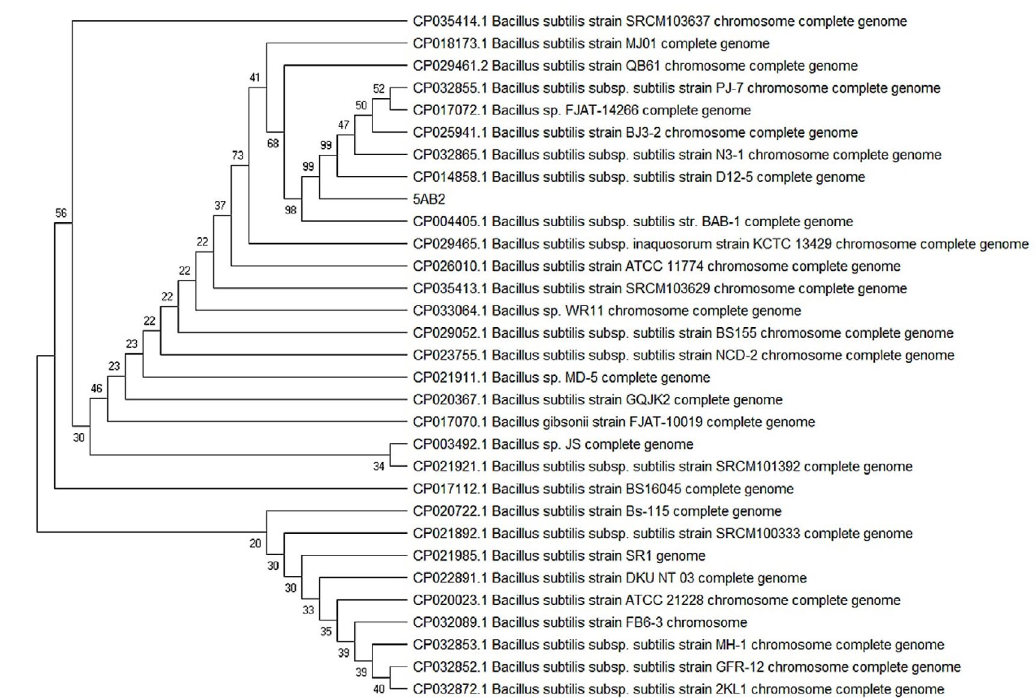
Fig. 5. Phylogenetic tree of strain 5AB2 together with its related neighbors was constructed based on 16S rDNA sequence using neighbor-joining and maximum likelihood method. Genbank accession numbers are given in parentheses.